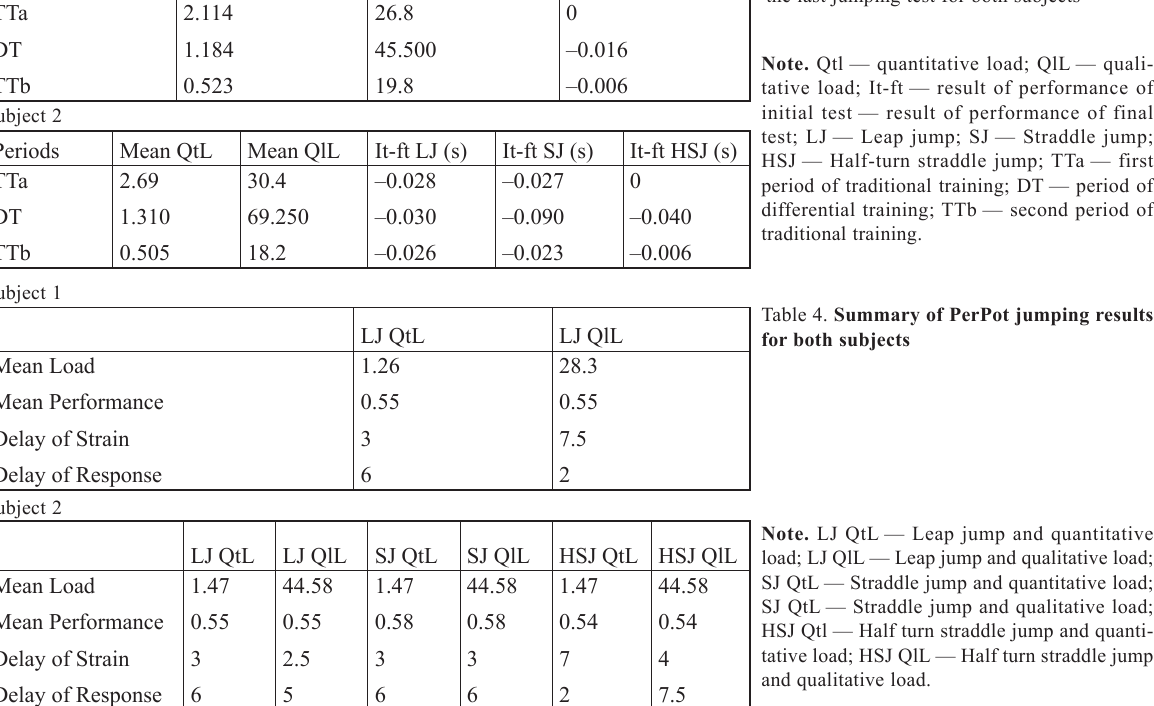
Table 3. Mean load for each sub-period and difference of performance between the fi rst and the last jumping test for both subjects